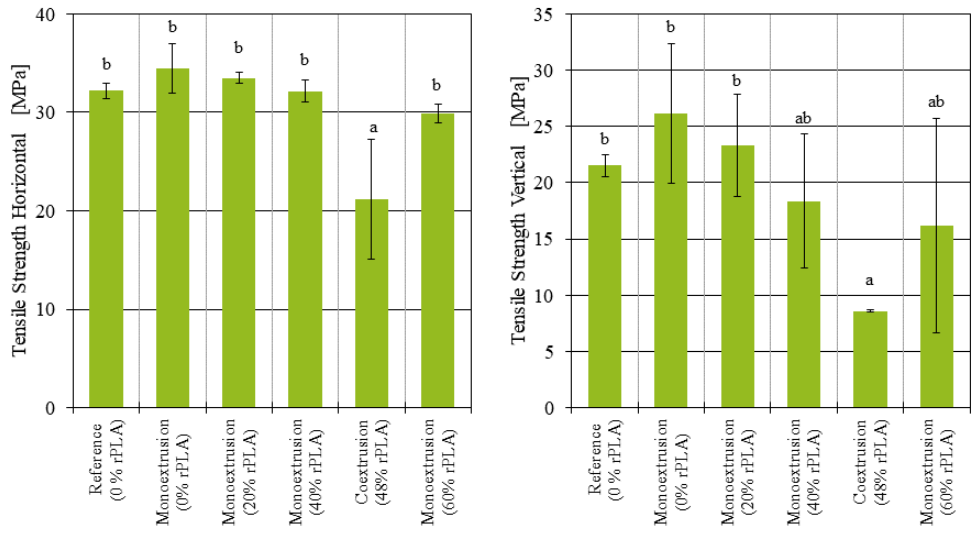
Figure 5. Tensile strength of additively manufactured samples manufactured in horizontal and vertical